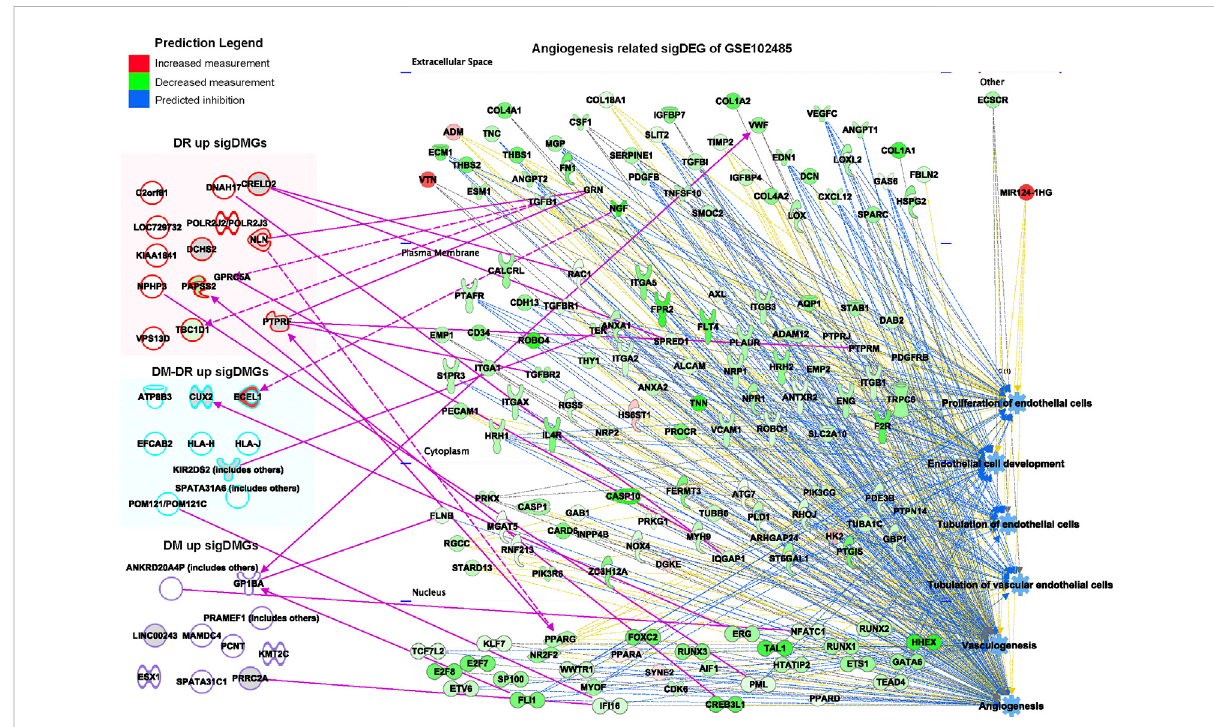
FIGURE 7 Network analysis of putatively susceptible or protective mutant genes with diabetic retinopathy – related upregulated genes enriched in the GSE102485 database. The summarized disease and function networks depict the interactions among the 54 signi fi cant differentially mutant genes with the angiogenesis-associated gene set from GSE102485. Green and red molecules indicate the upregulated and downregulated differently expressed genes of ocular tissues from patients with diabetic retinopathy vs. those without retinopathy, respectively. Figure legend displays gene and function symbol types and